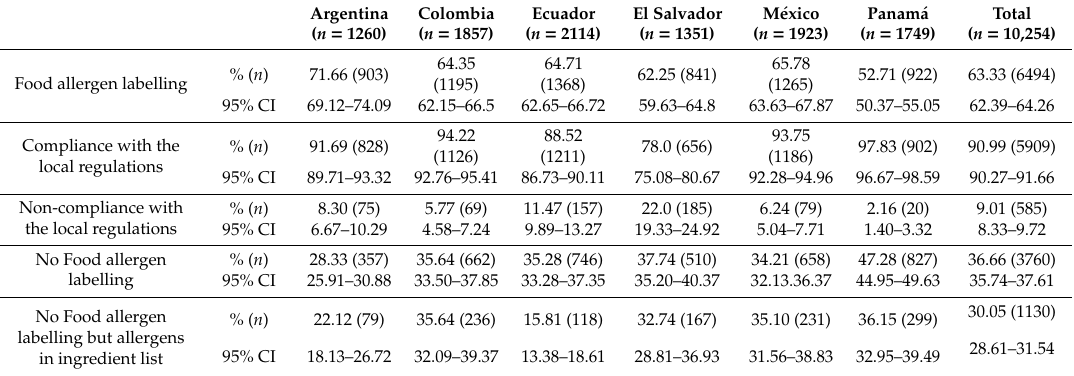
Table 1. Compliance and non-compliance with local regulations for the characteristics of food allergen labelling.